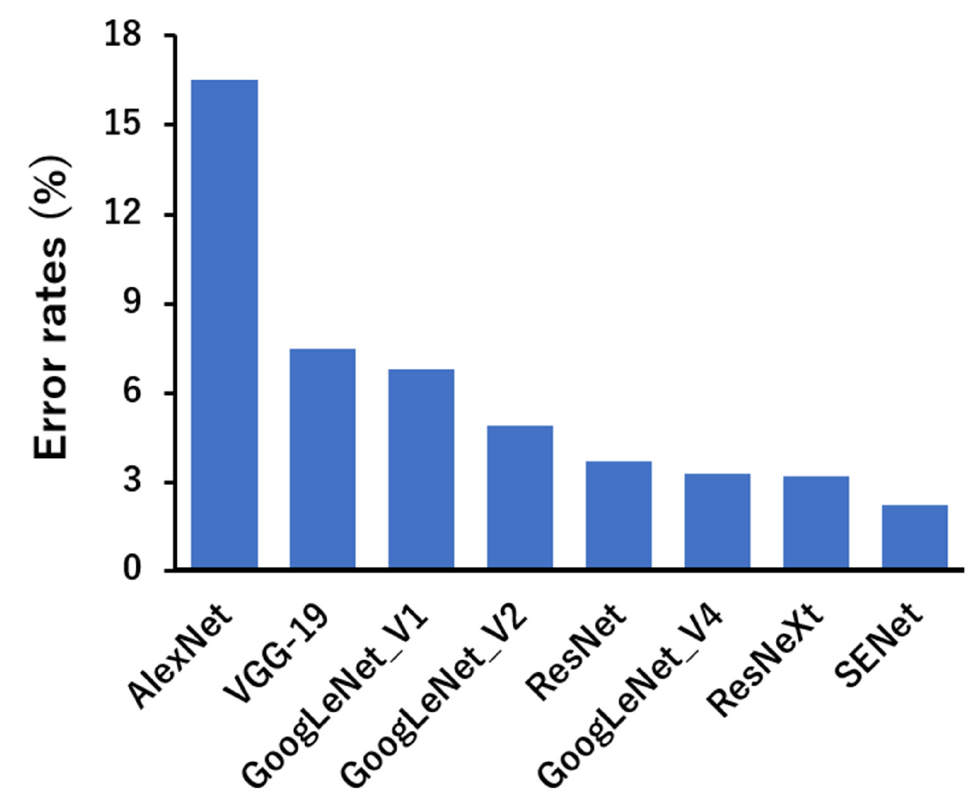
Figure 3. Performances of current popular deep neural networks on ImageNet [83].